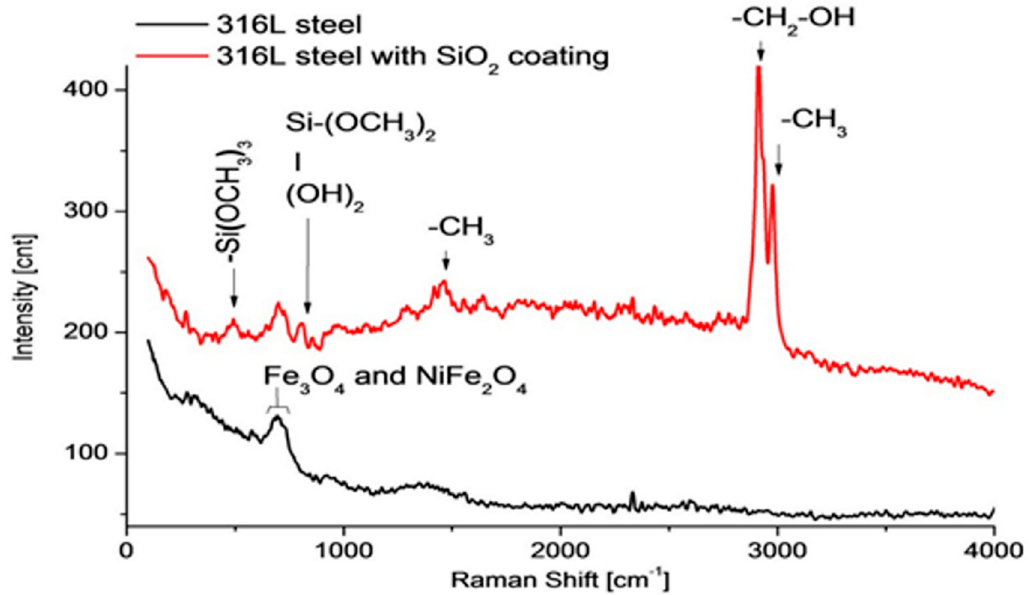
Figure 10. Raman spectra of 316L steel before (black spectrum) and after (red spectrum) SiO 2 coating deposition.